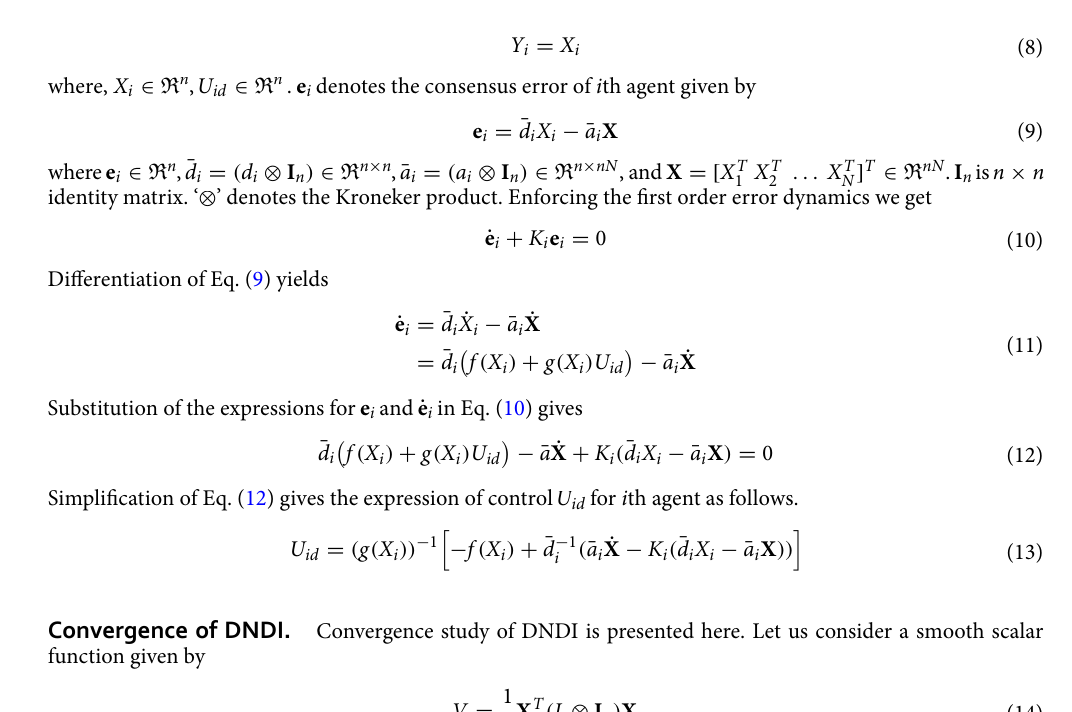
Figure 1. Block diagram of distributed NDI or